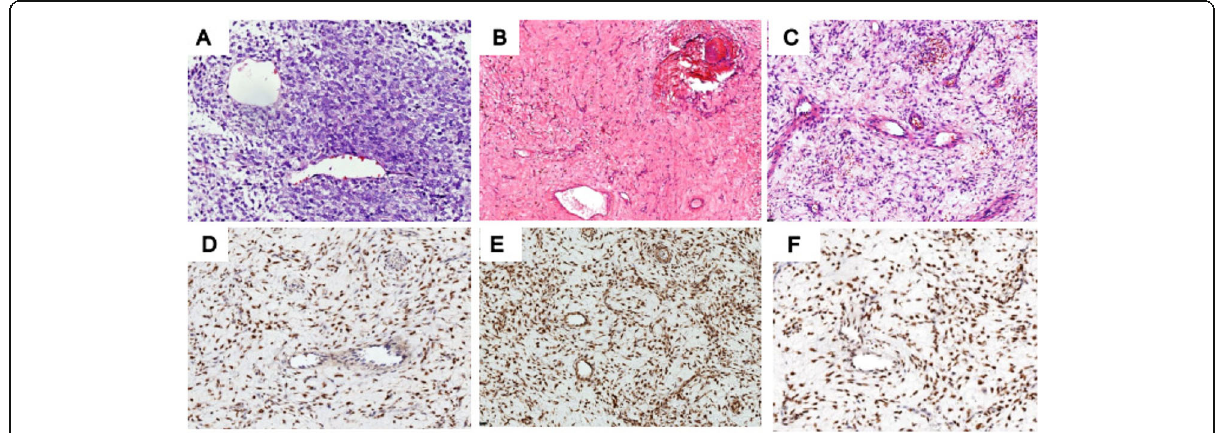
Fig. 2 Histological and immunohistochemical features of BCS that received pre-operative chemotherapy. A The tumor cells arranged in perivascular pattern (before chemotherapy). B The tumors showed good response to chemotherapy, with total replacement of tumor cells by hypocellular loose fibrous tissue. C A focal area of scant perivascular tumor cells created a vascular tumor-like appearance. D The residual cells after chemotherapy were strong BCOR-positive in the nuclei. E The residual cells after chemotherapy were CCNB3 positive. F The residual cells after chemotherapy were TLE1 positive. Haematoxylin and eosin, original total magnification ×200 ( A - C ). Immunoperoxidase, original total magnification ×200 ( D - F